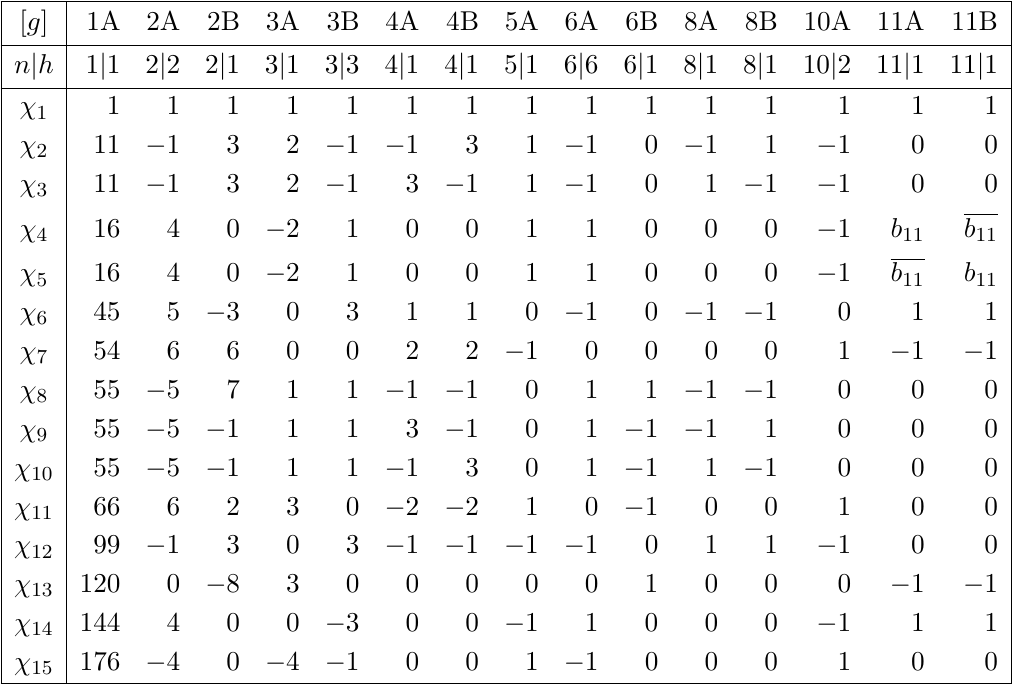
Table 1 . Character table of M 12